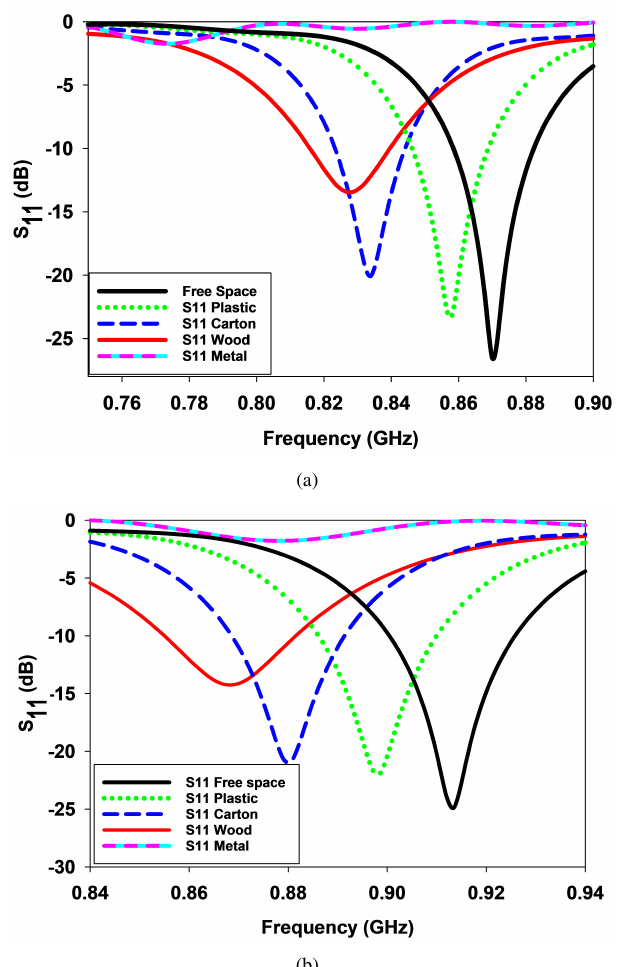
FIGURE 14: Simulated reflection coefficients of both config- urations (Ant1 and Ant2) mounted on different substrates: (a) Ant1 and (b)